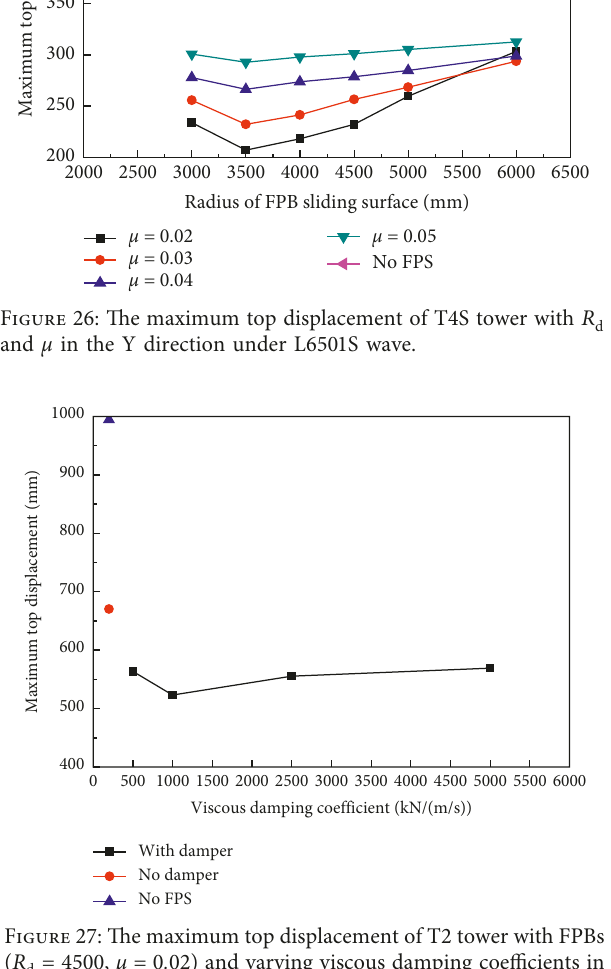
Figure 29: The maximum top displacement of T4S tower with FPBs ( R d 4500, μ 0 . 02) and varying viscous damping co- (cid:31) (cid:31) efficients in the X direction under L0689S